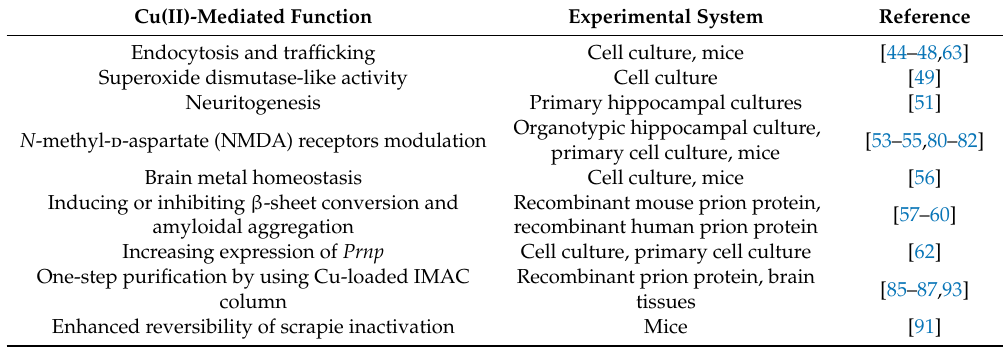
Table 1. PrP C functions suggested by Cu(II)